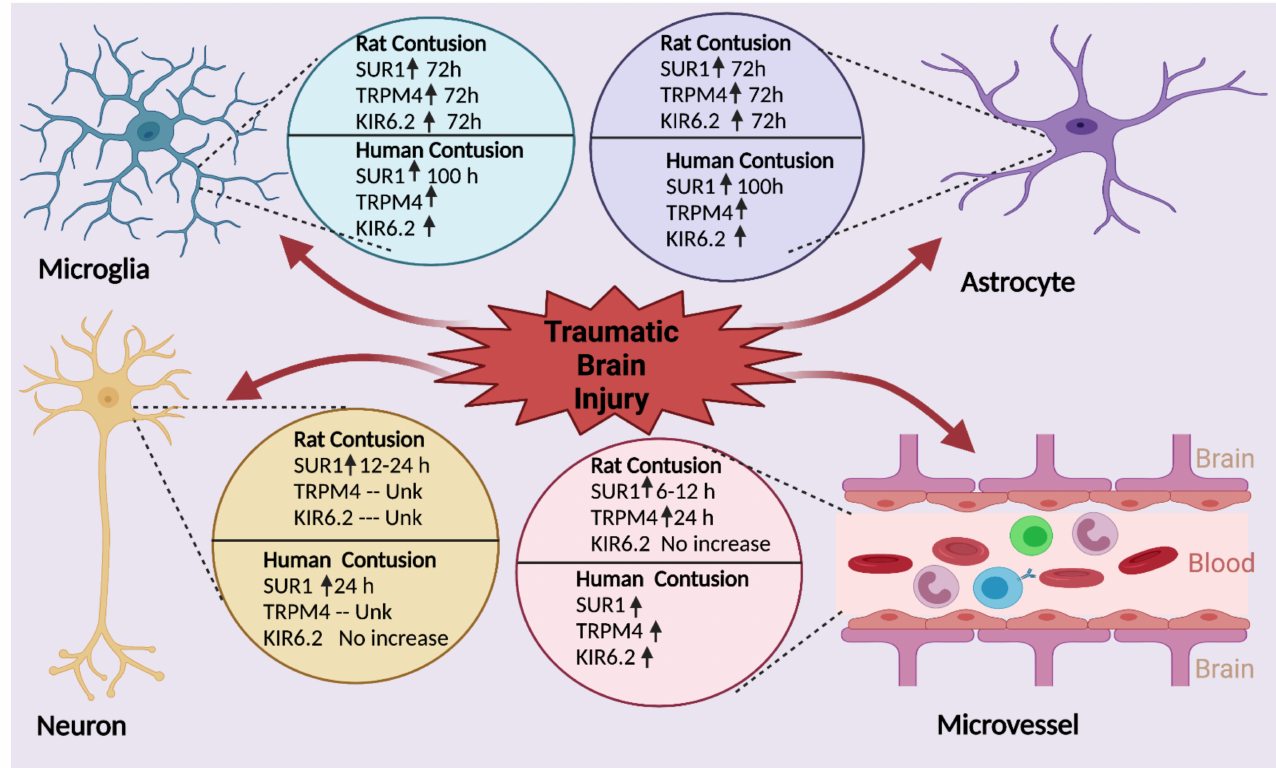
Figure 6. Schematic representation of SUR1, TRPM4, and KIR6.2 expression and timelines in neuron, microglia, astrocytes, and microvessels after TBI in rodents and humans. Figure created with BioRender.com